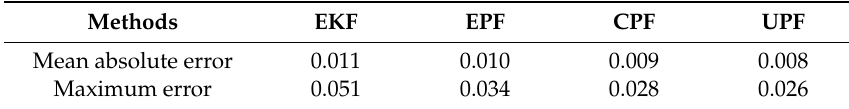
Figure 6. Battery model outputs under City test: ( a ) model output; and ( b ) model error. Table 2. Estimated accuracy.